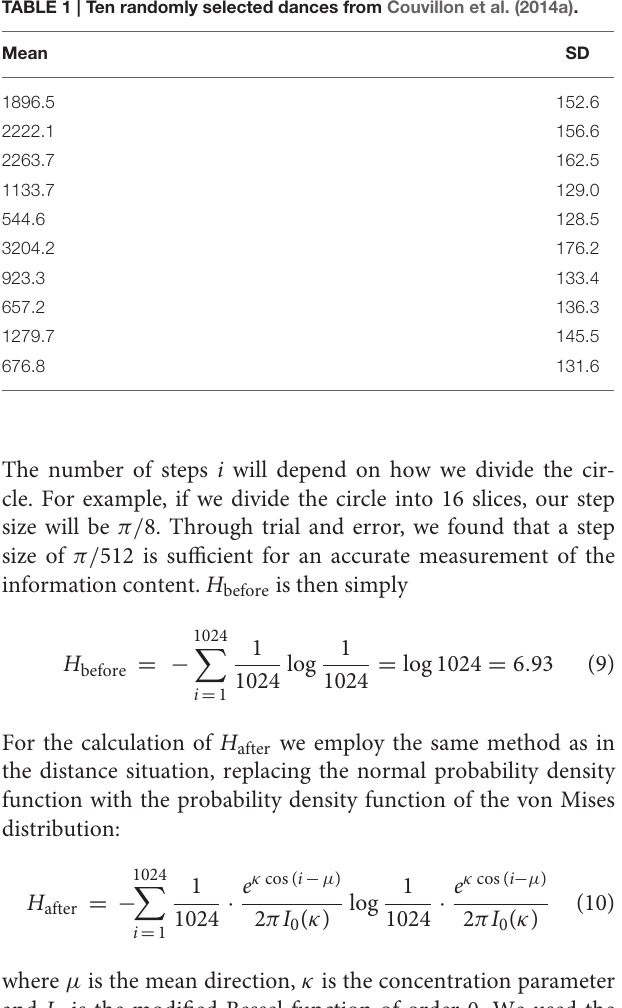
TABLE 1 | Ten randomly selected dances from Couvillon et al.